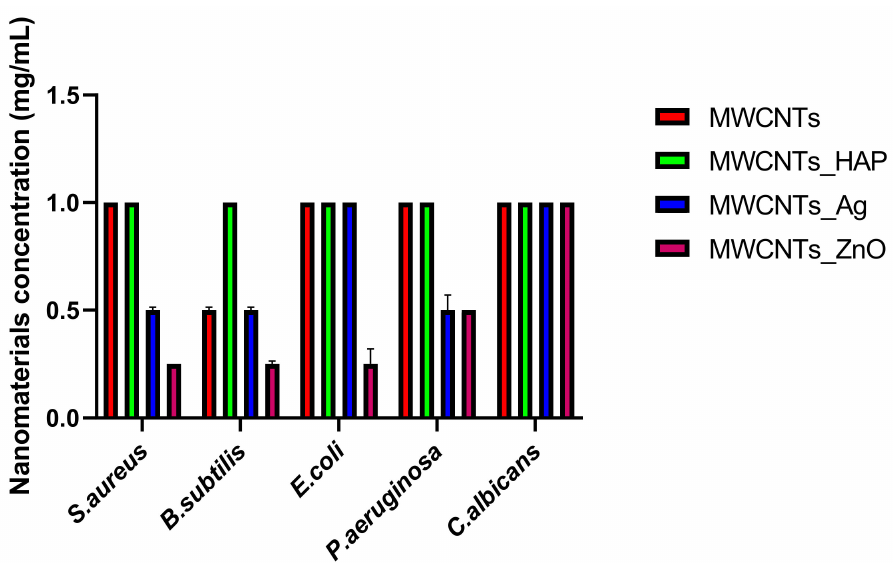
Figure 11. Graphical representation of MIC values of MWCNTs and decorated MWCNTs on microbial strains tested at 24 h incubation at 37 ◦ C. Data represented were mean of triplicate values with standard deviation.